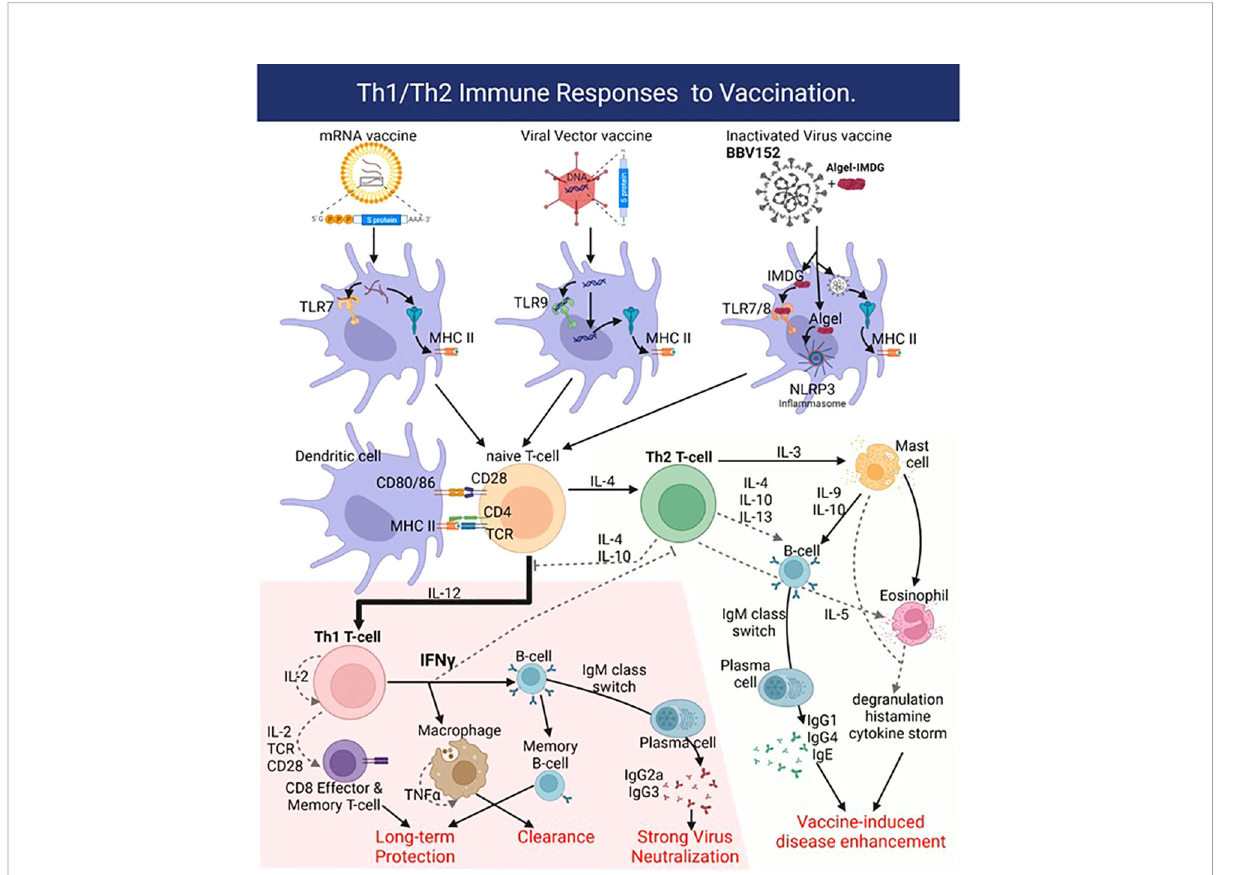
FIGURE 2 Vaccines deliver the SARS-CoV-2 antigen into dendritic cells (DC) using lipid nanoparticles (mRNA vaccines), adenoviral vectors, or in the case of BBV152 by using the inactivated SARS-CoV-2 virus. Adjuvant activity of the vaccines triggers innate sensors like the mRNA sensor Toll-like receptor 7 (TLR7) or double-strand DNA sensor TLR9 for mRNA and Viral Vector vaccines, respectively. The Algel-IMDG adjuvant in BBV152 activates TLR7/8 (IMDG) and the NLRP3 in fl ammasome (Algel). The resulting production of IL-12 drives naïve T-cells towards the pro-in fl ammatory Th1-biased response that generates strongly neutralizing antibodies (IgG1, IgG3 subtypes) and virus-speci fi c CD8 effector T-cells to clear the infection. Generation of viral antigen-speci fi c memory B- and CD8 T-cells affords long-term protection. Production of IL-4 however drives a Th2-biased response with high titers of IgG4 and IgE, along with recruitment and activation of mast cells and eosinophils, which causes vaccine-induced disease enhancement or antibody-dependent enhancement. Figure created with